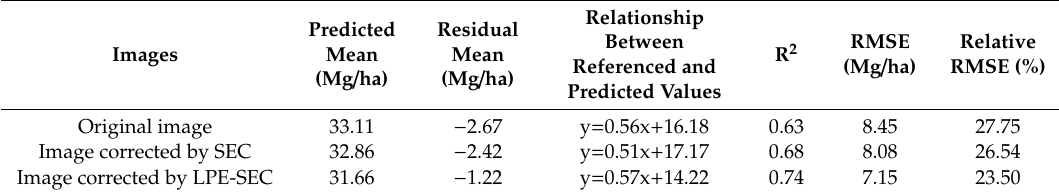
Table 8. Estimation accuracy of the forest carbon density by combining the sample plot data with the original image and the images corrected by the traditional SEC and LPE-SEC, respectively. R 2 : determination coe ffi cient. RMSE: root mean square error. At the significance level of 0.05, the confidence interval of the validation data is (26.71, 34.07) (Mg / ha).